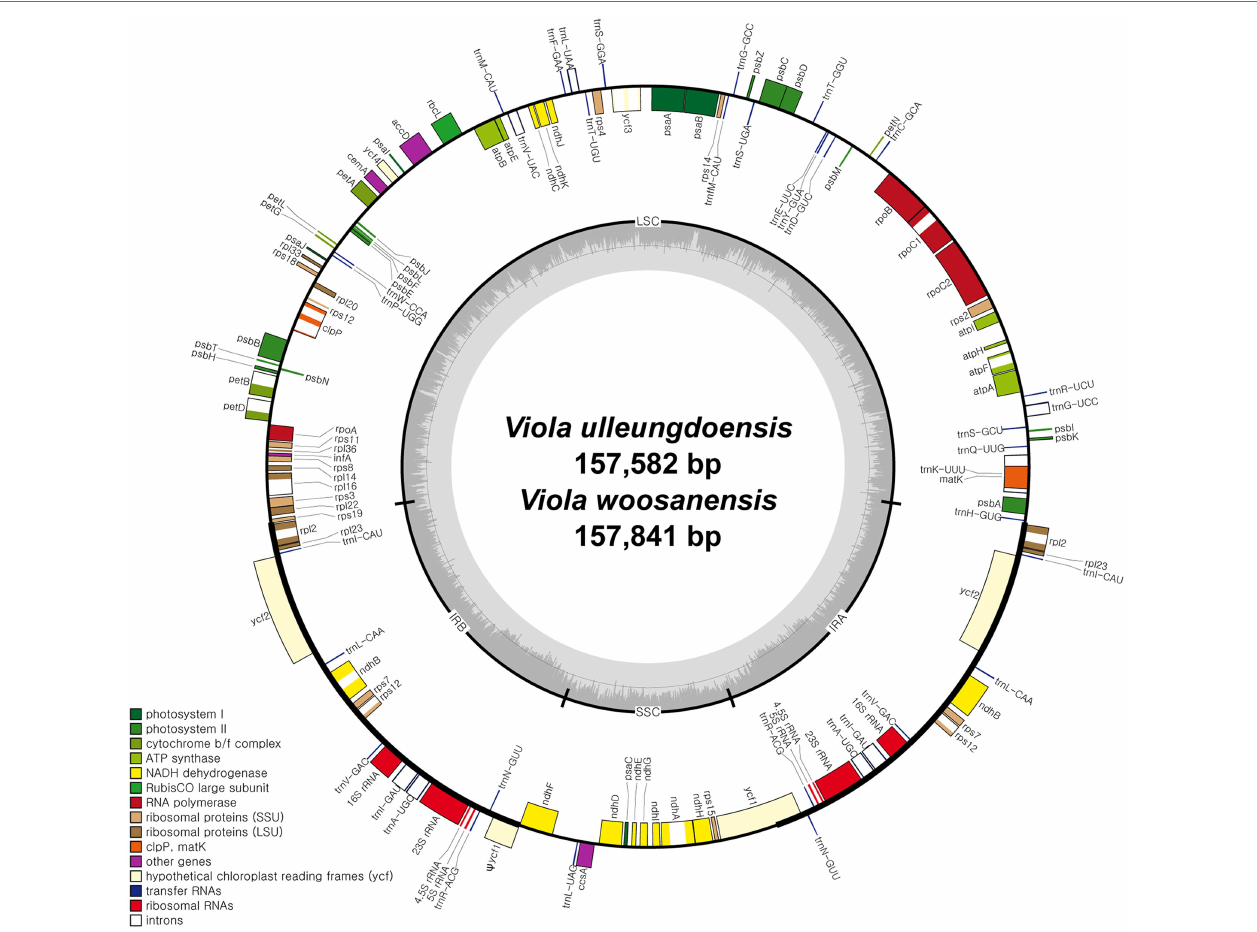
FIGURE 1 | Complete plastome maps of Viola ulleungdoensis and Viola woosanensis . Genes located outside the circle are transcribed clockwise, whereas those located inside are transcribed counter clockwise. The gray bar area in the inner circle denotes the guanine-cytosine (GC) content of the genome, whereas the lighter gray area indicates the adenosine-thymine (AT) content of the genome. Large single copy, small single copy, and inverted repeat are indicated by LSC, SSC, and IR, respectively. Ψ indicates